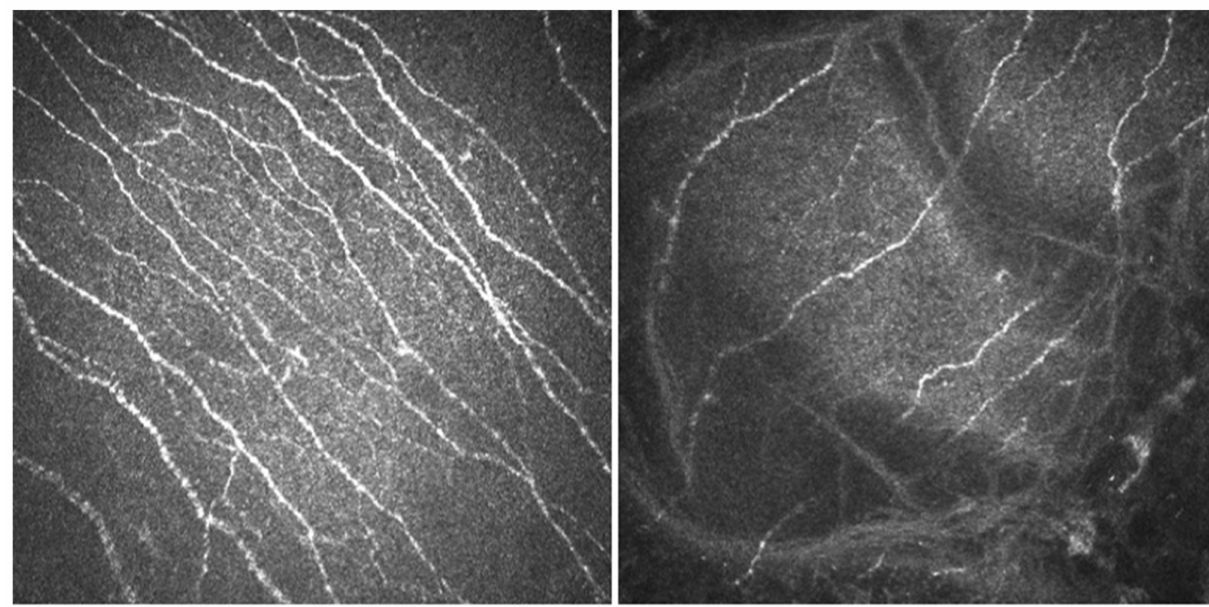
Figure 1. In vivo confocal microscopy images of the central cornea in a healthy control and in a mercury-intoxicated patient. For both corneas, the images were taken at a depth of 50–80 µ M. ( Left ) In the healthy control subject, the following measurements were made: nerve density, 15/mm 2 ; tortuosity, 2; mean nerve length, 27.94 mm/mm 2 ; nerve branch density, 7/mm 2 ; dendritic cell density, 4/mm 2 ; and reflectivity, 109.1 gray units. ( Right ) In the mercury-intoxicated subject, the following measurements were made: nerve density, 8/mm 2 ; tortuosity, 3; mean nerve length, 13.77 mm/mm 2 ; nerve branch density, 3/mm 2 ; dendritic cell density, 0.5/mm 2 ; and reflectivity, 76.29 gray units.